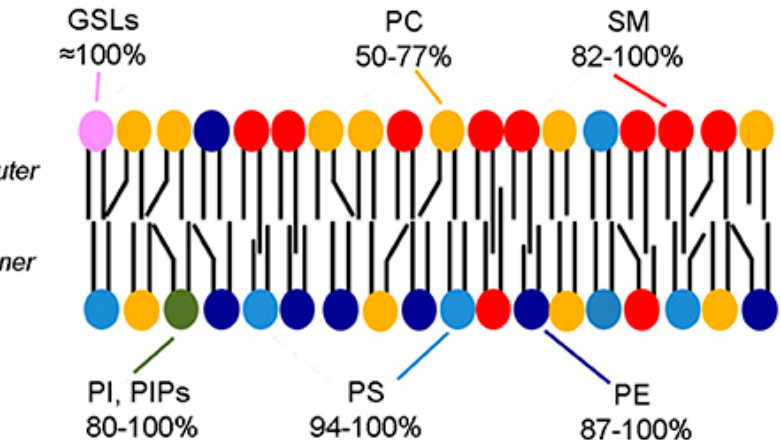
Figure 5. “Phospholipid asymmetry in the erythrocyte membrane” [22] [Reuse permitted by Creative Commons Attribution License (CC BY)].